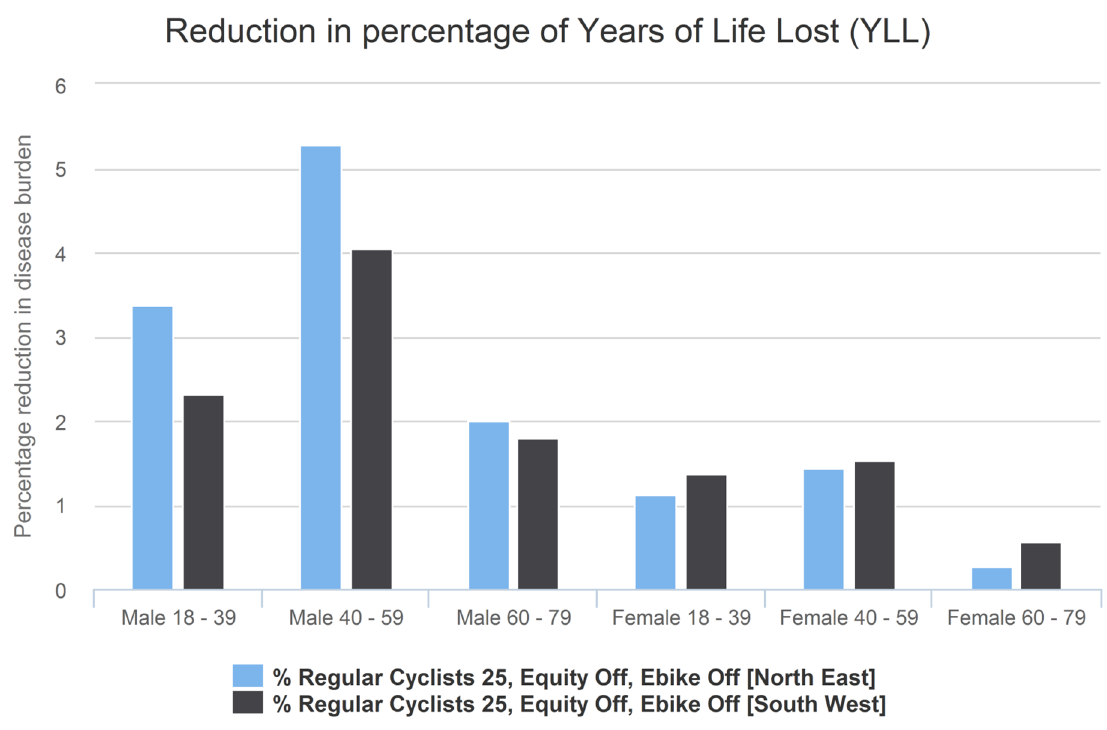
Fig 8. Reduction in percentage of number of deaths. YLL, year of life lost.